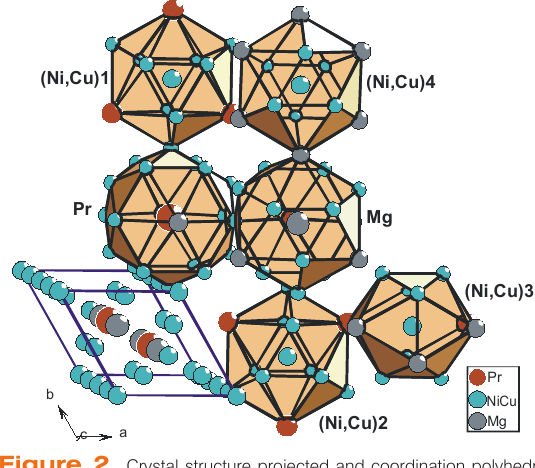
of the atoms in the PrMg